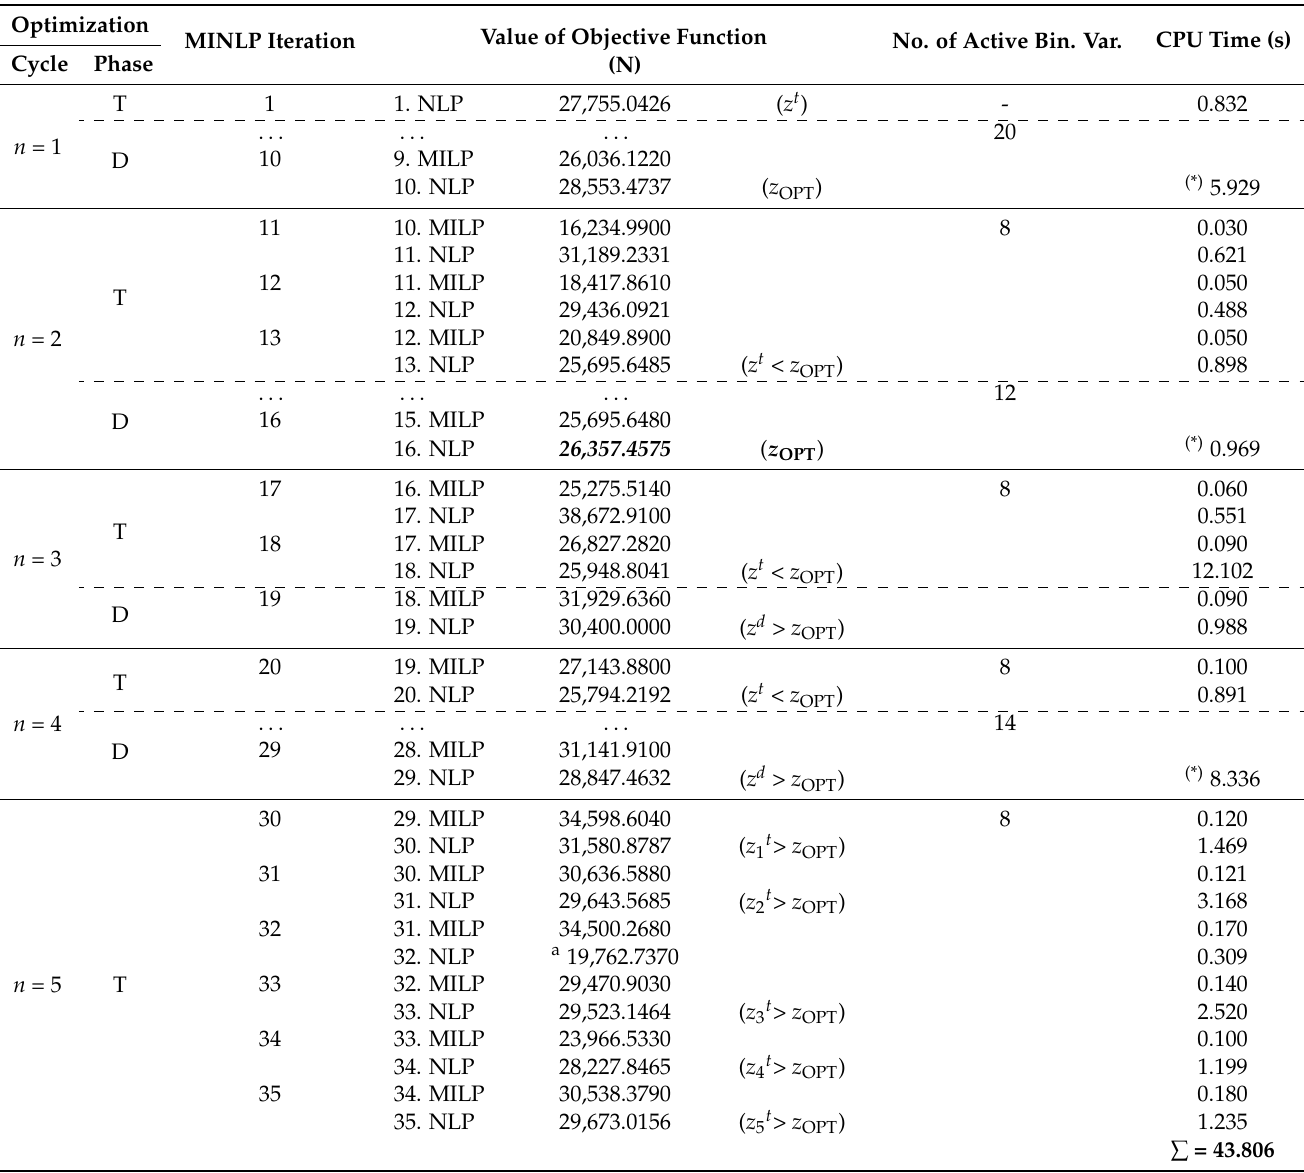
Table A4. Convergence of the Modified OA/ER algorithm and the STP strategy, example TC10d (topology and shape optimization, with buckling